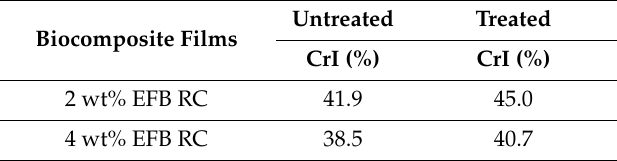
Table 1. The crystallinity index (CrI) of untreated and MMA-treated EFB RC biocomposite films containing 2 and 4 wt%